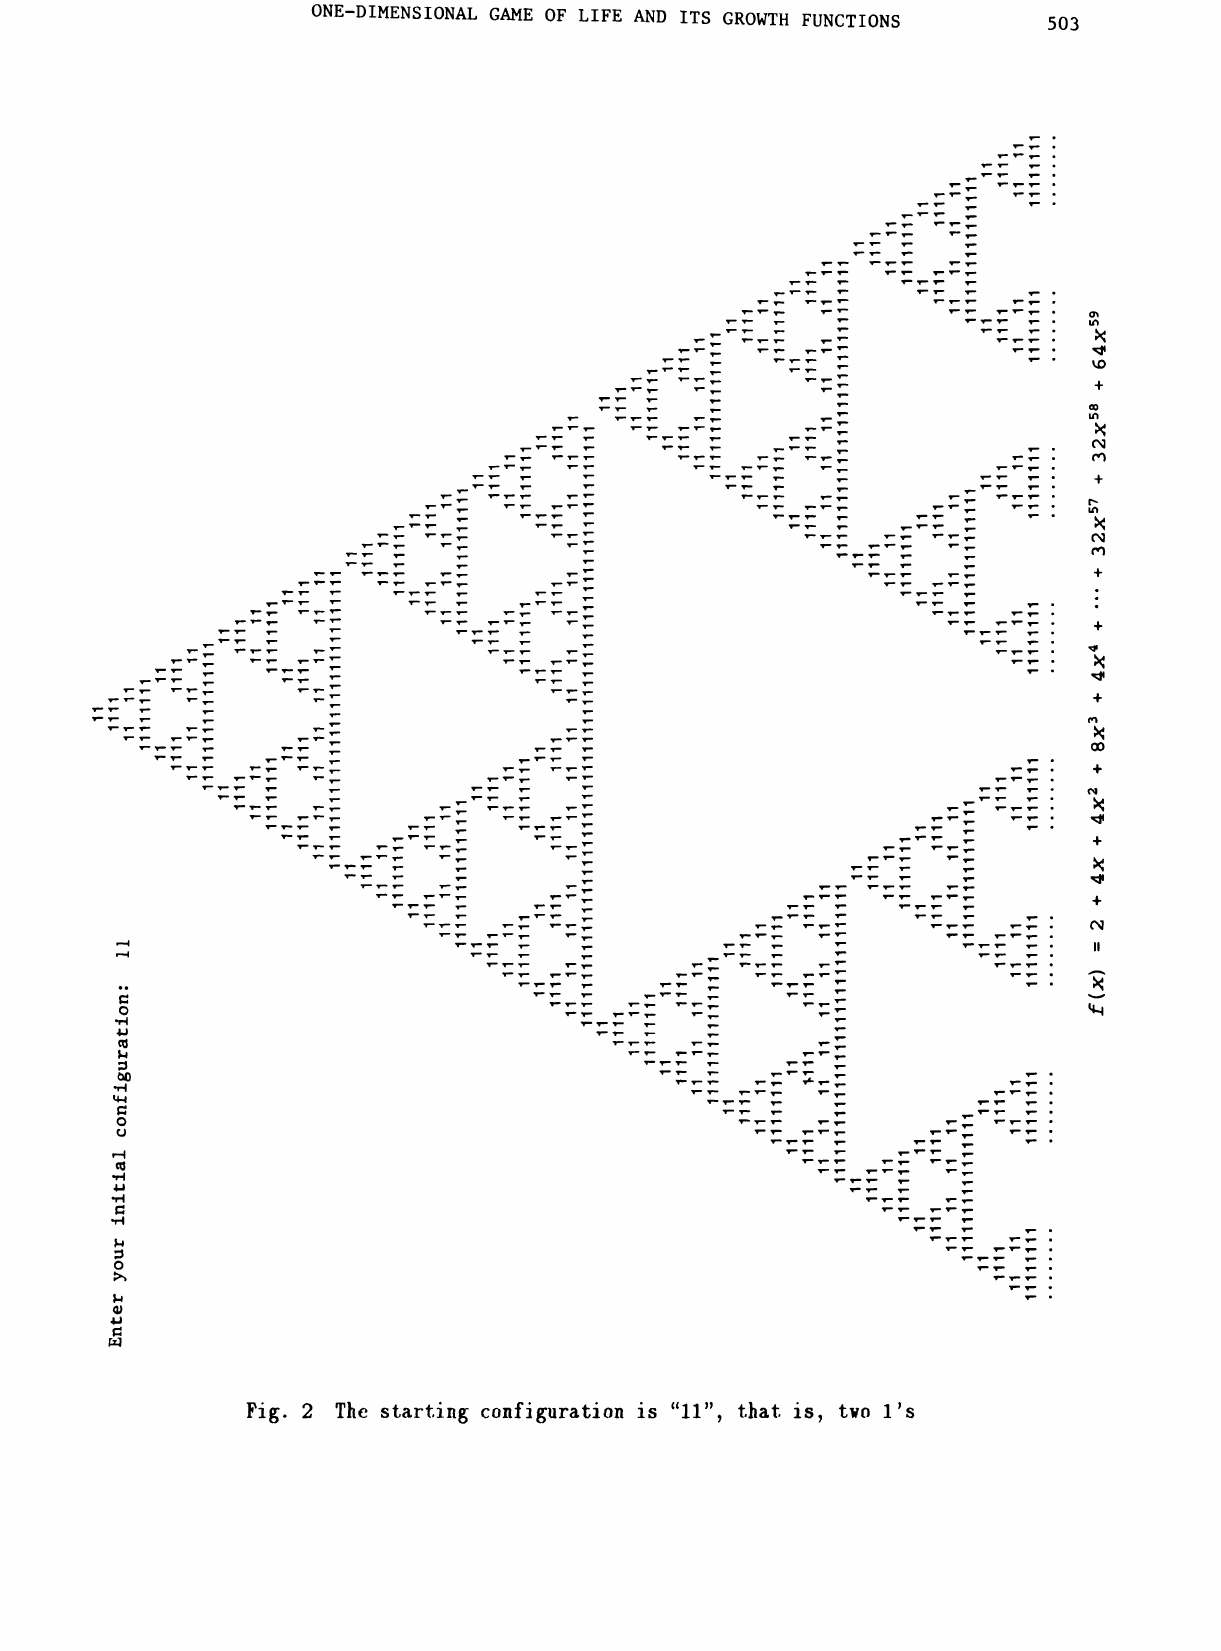
Fig. 2 The starting configuration is "11" that is two